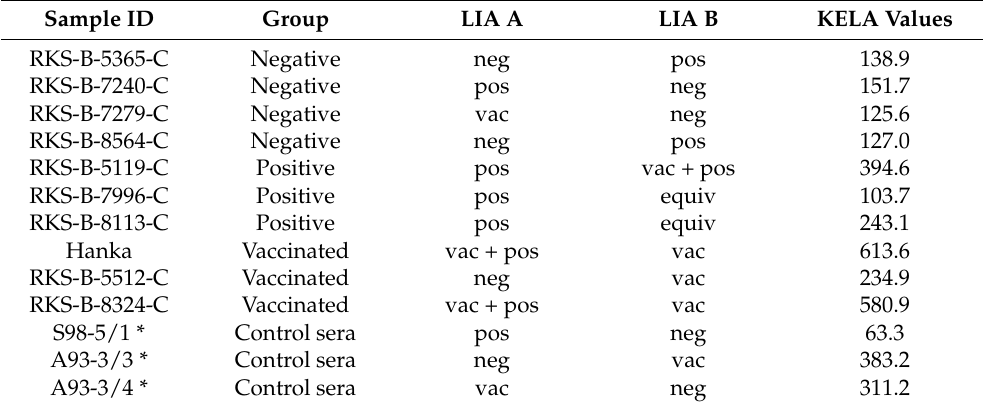
Table 5. Canine samples with divergent results in the two LIAs. KELA-results below 100 are considered as negative. KELA levels above 100 need confirmation by a LIA.